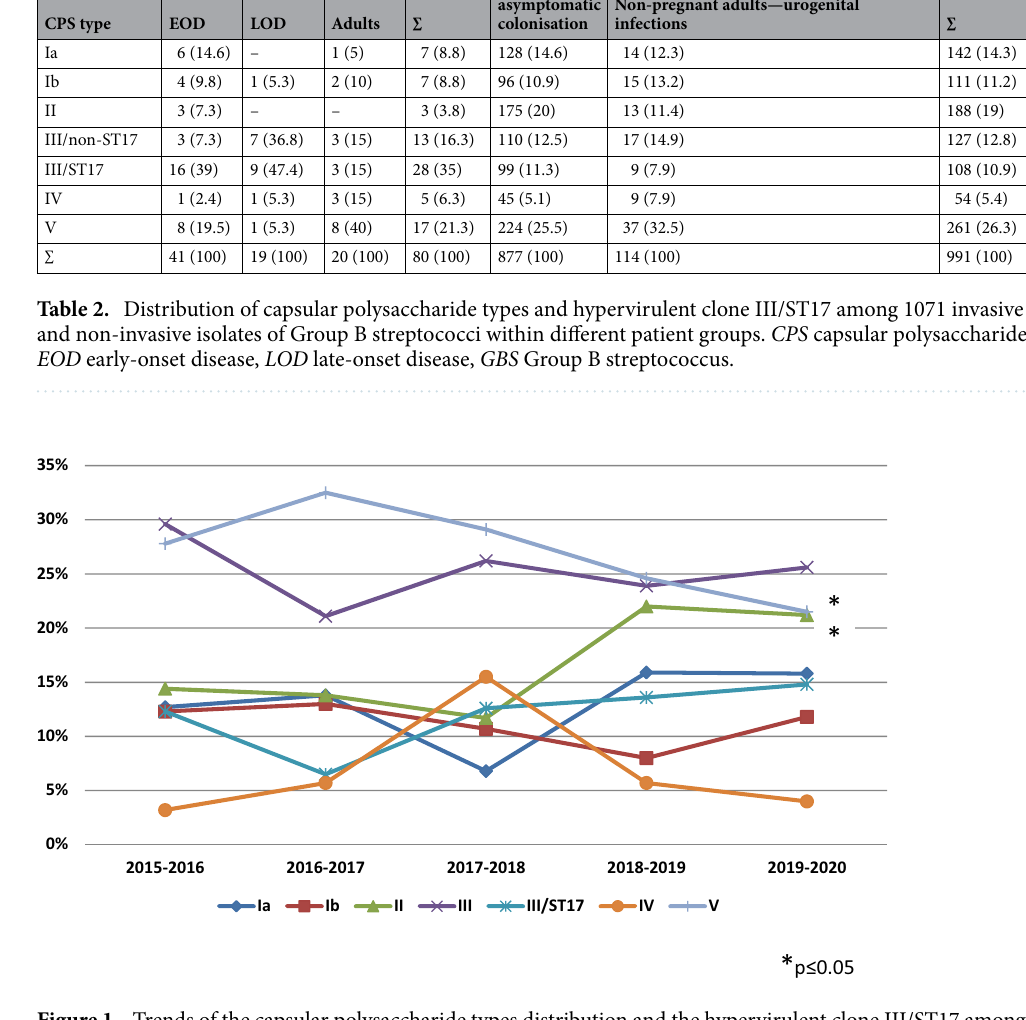
Figure 1. Trends of the capsular polysaccharide types distribution and the hypervirulent clone III/ST17 among 1071 invasive and non-invasive isolates of Group B streptococci in Serbia during a 5-year